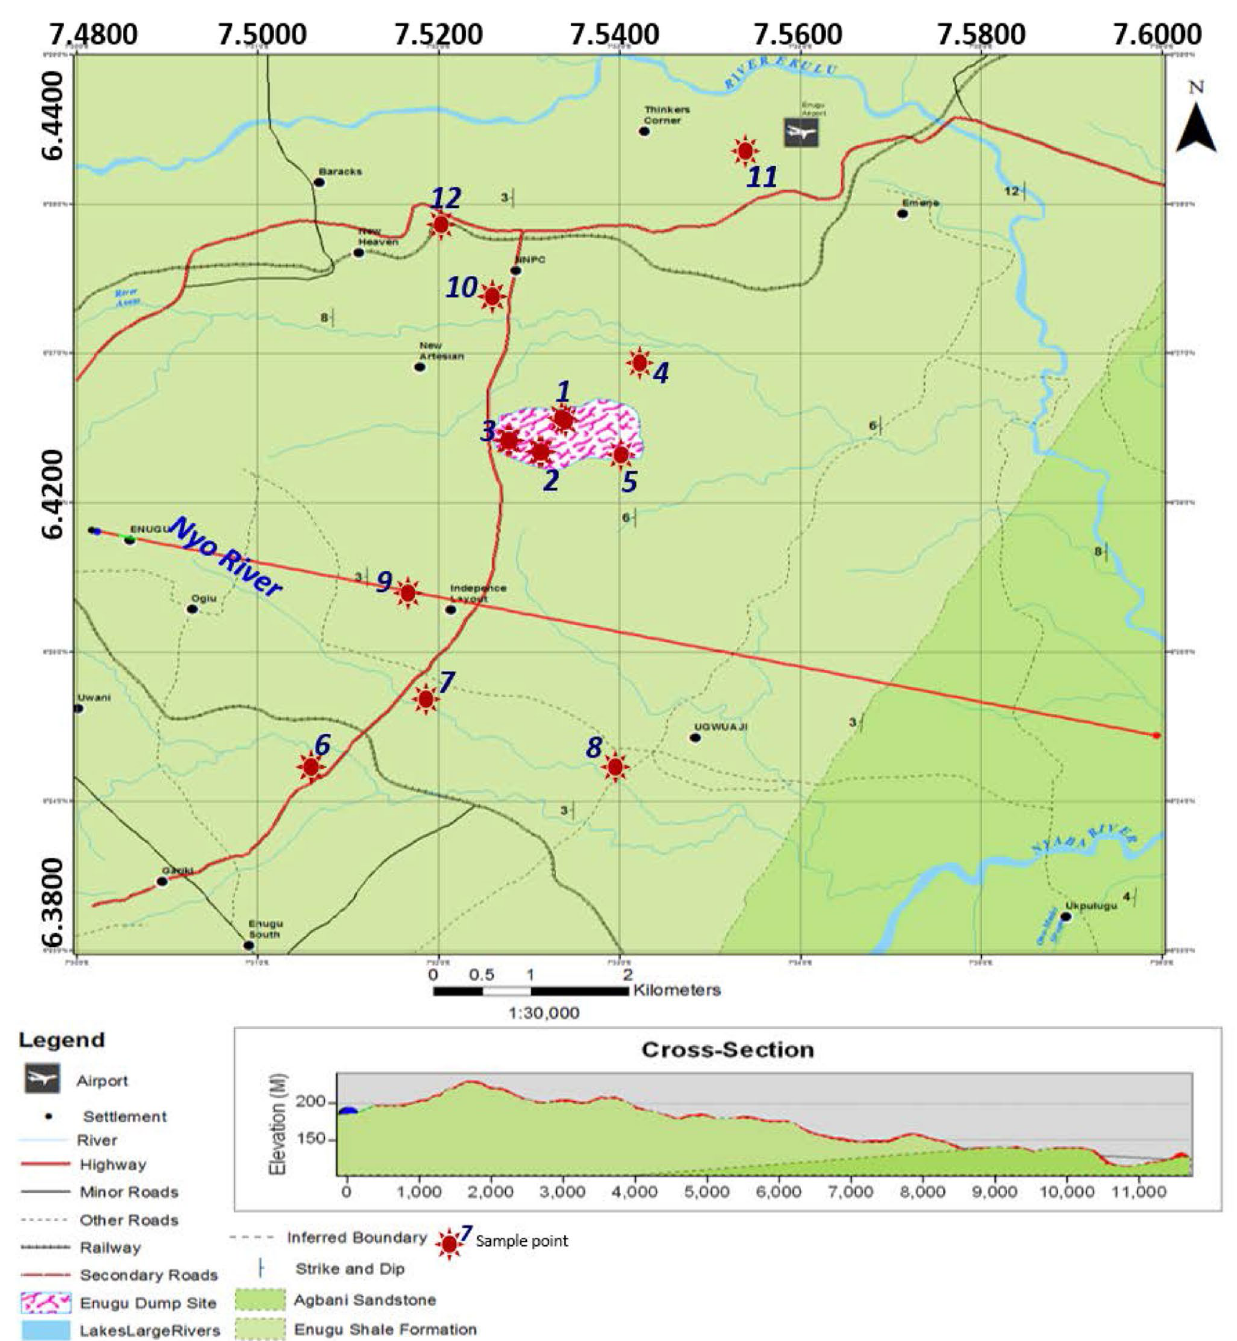
Fig. 3 Geological map of the study